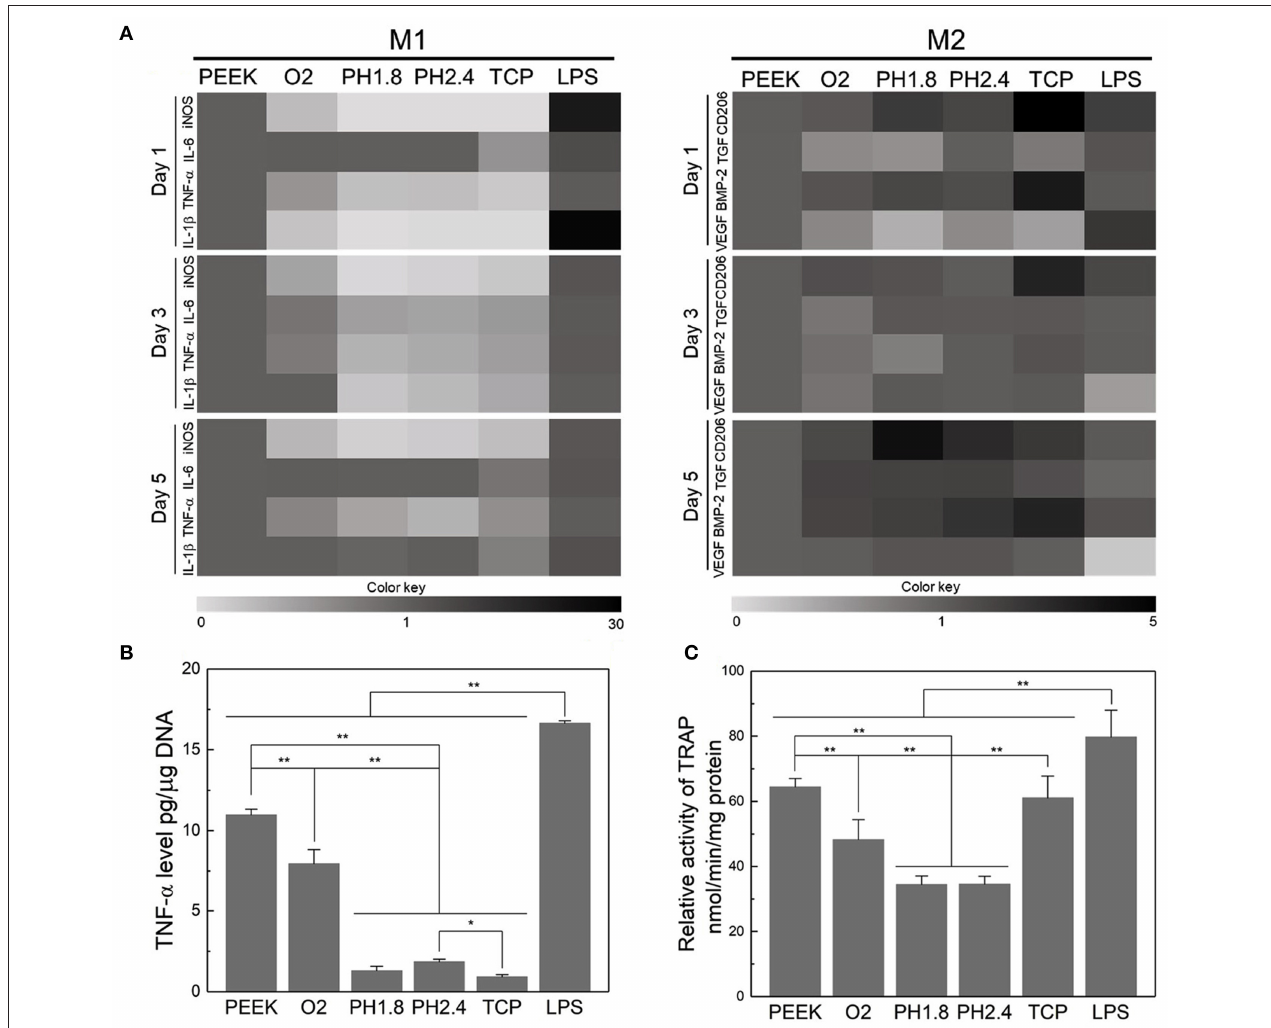
FIGURE 4 | Evaluation of the acute inflammatory responses of RAW264.7 cells on different samples. (A) Heat map of the RT-PCR results of M1- and M2-related genes after incubation for 1, 3, and 5 days. (B) Level of TNF- α released by RAW264.7 cells after culturing for three days. (C) TRAP activity after culturing for 8 days to evaluate the osteoclastic differentiation of RAW264.7 cells. * p < 0.05, ** p < 0.01. Reproduced from Gao et al. (2020). Copyright (2020), with permission from Elsevier.